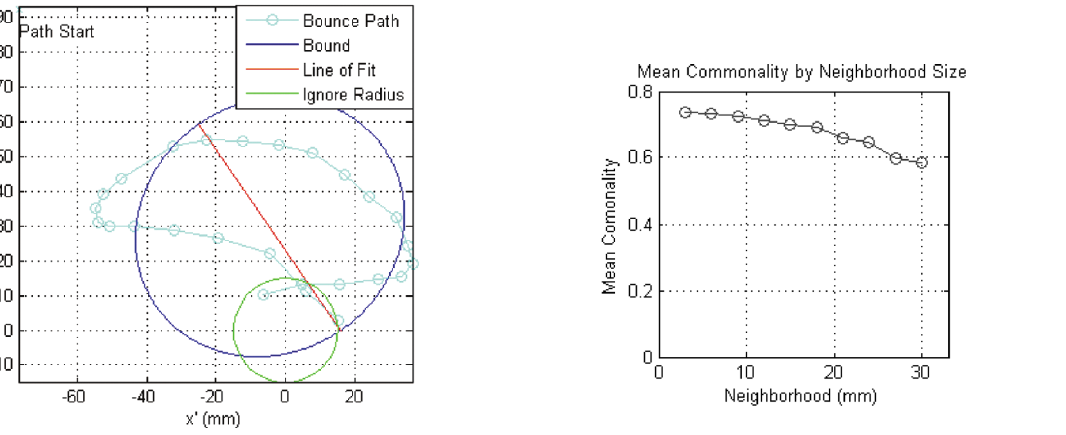
Fig. 20. The commonality of each sample to its neighbors decreases as sam- ples from further away are included. The mean commonality drops from 74% at a 3 mm radius about the starting point to 59% at a 30 mm